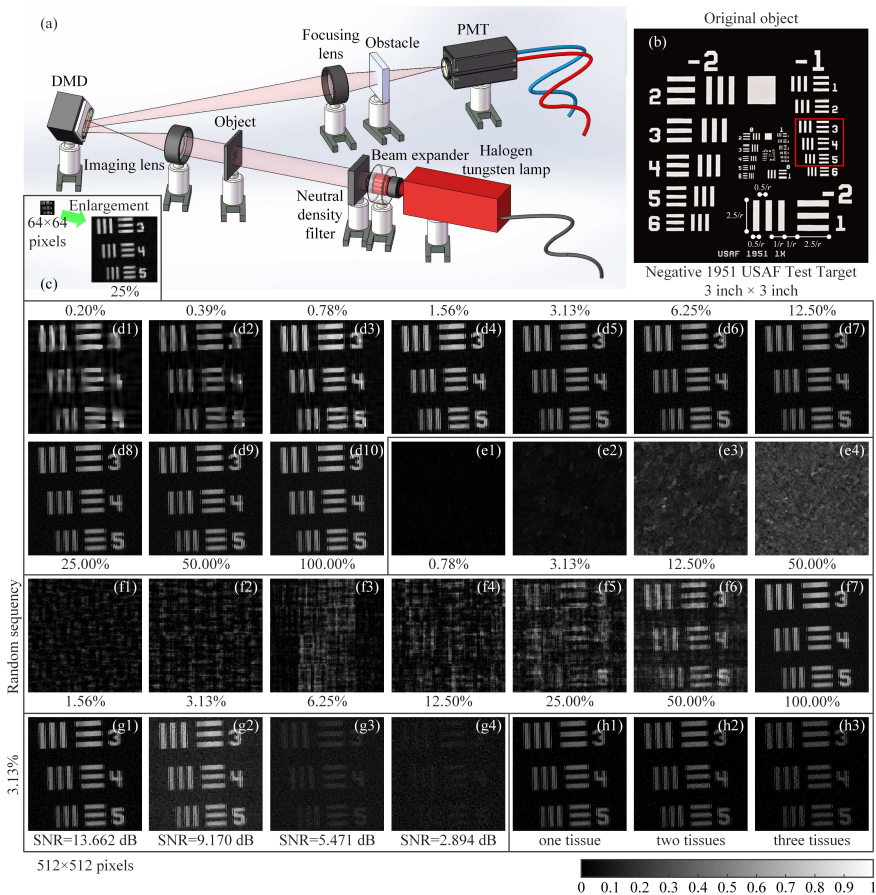
Figure 9. Schematic of the optical setup and experimental results. ( a ) The thermal light from a Halogen tungsten lamp illuminates the object through a beam expander and some NDFs, and then the light is projected onto a DMD. The reflected light is collected by a PMT through a focusing lens. ( b ) A negative 1951 USAF resolution test chart of 3 inch × 3 inch is treated as an object to be detected. ( c ) The recovered image of 64 × 64 pixel size with a sampling ratio of 25%. ( d1 – d10 ) Reconstructed images of 512 × 512 pixels using the sampling ratios from 0.2% (the limit) to 100% with a 2 × stepping increase, when the piece numbers are in their ascending order. ( e1 – e4 ) Retrieved images of 512 × 512 pixels with a 4 × stepping increase in the sampling ratio, when the piece numbers are in their descending order. ( f1 – f7 ) For comparison, the recovered images using traditional random-natural-ordered Hadamard sensing matrix are given, with the sampling ratios changing from 1.56% to 100.00% with a 2 × stepping increase. ( g1 – g4 ) The reconstructions via our method under different SNRs, acquired without obstacles. ( h1 – h3 ) The results using our method with obstacles (some tissues, the number of which is increasing). The results in the last row all use a sampling ratio of